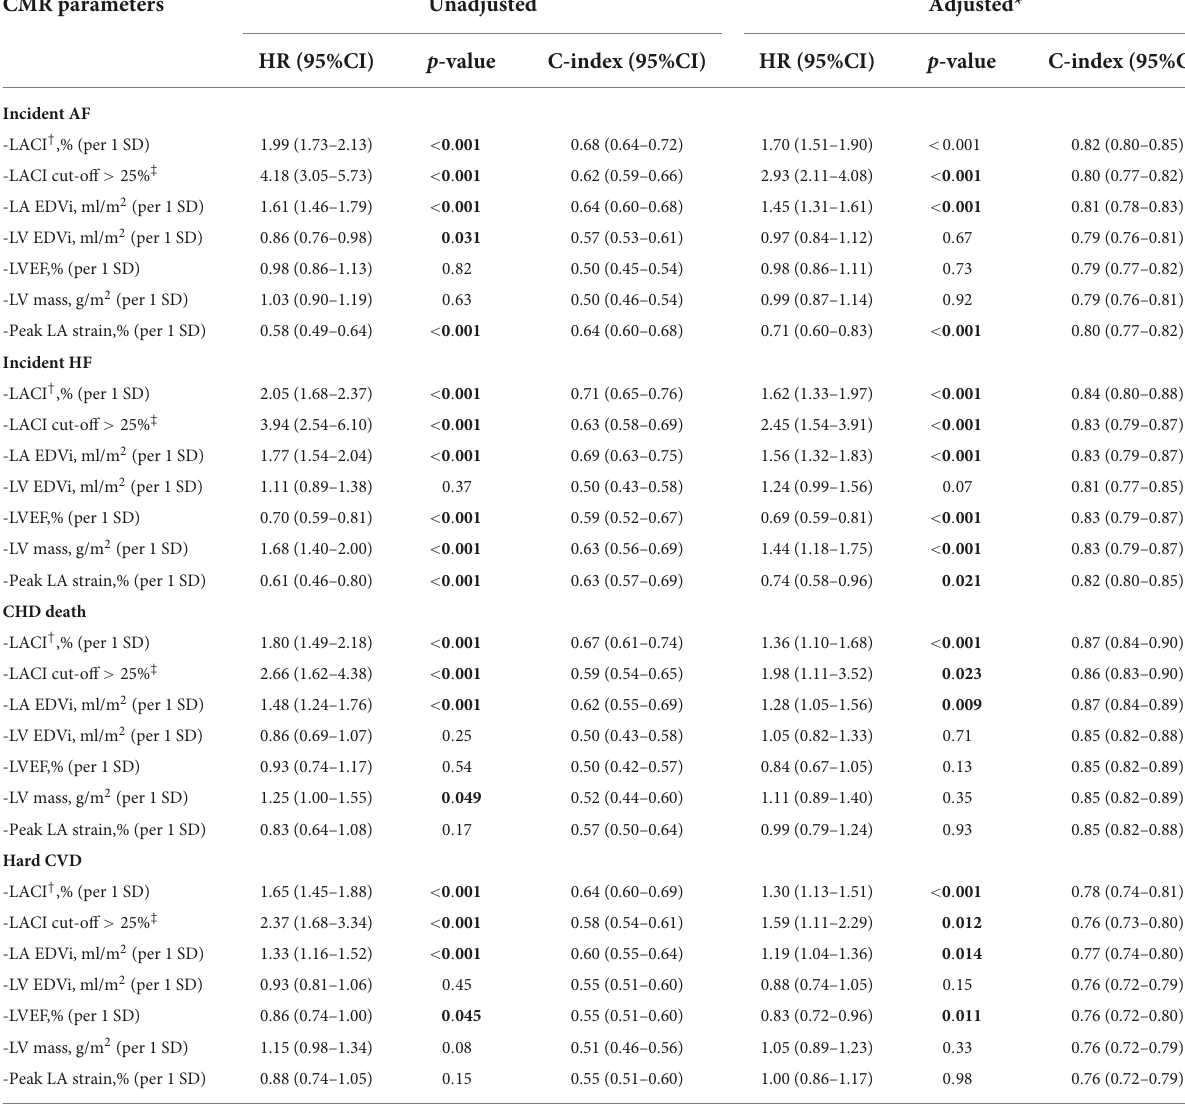
TABLE 2 Univariable and multivariable analysis of CV events occurrence according to left atrioventricular coupling index and other LA or LV parameters in all women ( n = 2,087). CMR parameters